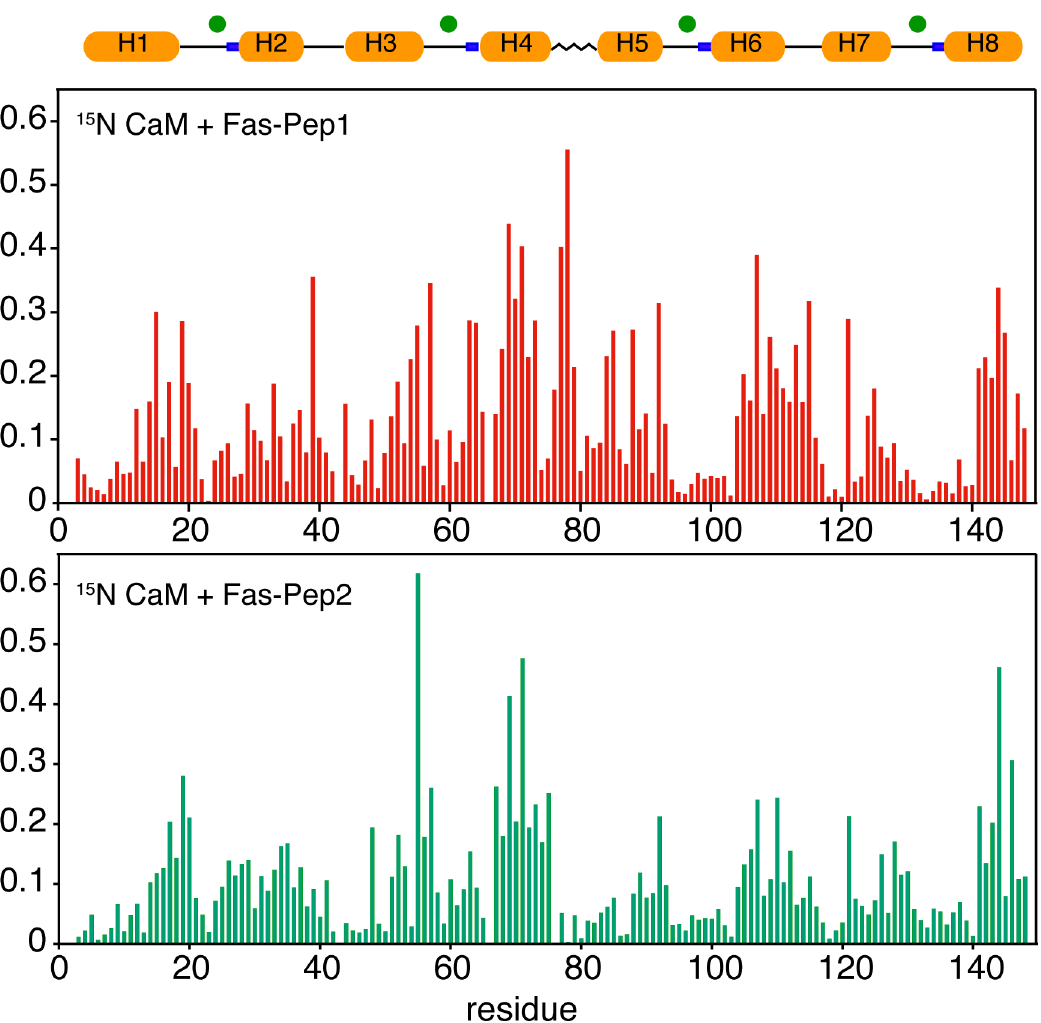
Fig 7. Histograms of the chemical shift changes of Ca 2+ /CaM upon binding to FasDD peptides. A schematic representation of the secondary structure of Ca 2+ /CaM is shown. Calcium ions are indicated by green dots. Histograms of normalized chemical shift changes vs. residue number for Ca 2+ /CaM bound to Fas-Pep1 and Fas-Pep2. Notice the differences in the chemical shift changes especially in the central linker (H4/H5) of Ca 2+ /CaM, which may suggest significant differences in the binding mode of FasDD